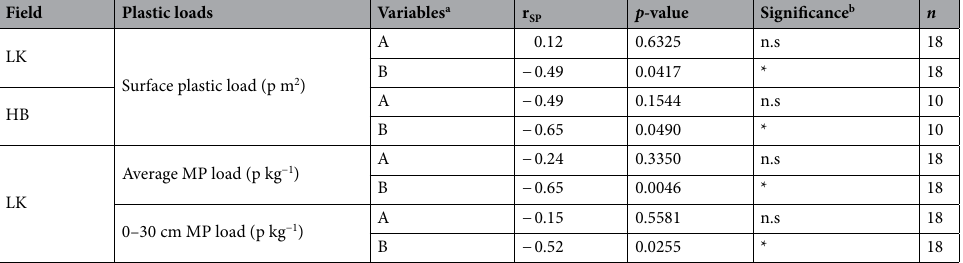
Table 2. Spearman coefficients r Sp of correlations between plastic loads (surface and depth sampling) and terrain height or distance to sewage sludge application area. a A: Surface height at central sector point (m a.s.l.), B: Distance to central sewage sludge application area (m). b Significant * if p ≤ 0.05, n.s = not